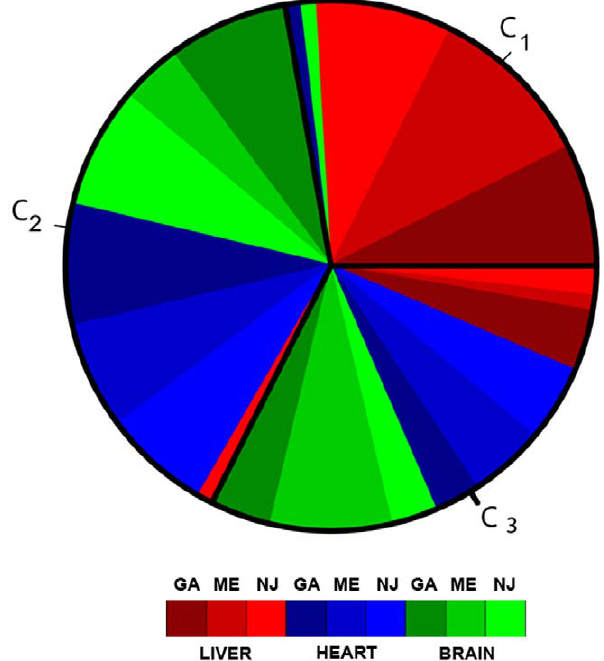
Figure 2. Pie plot of the percentage of tissue samples assigned by NetSel to each community detailed in Table 11. The green dye indicates the brain, the red dye indicates the liver and the blue dye indicates the heart. Each color has three intensities: light for the New Jersey ( NI ), medium for the Maine ( ME ) and dark for the Georgia ( GA ).